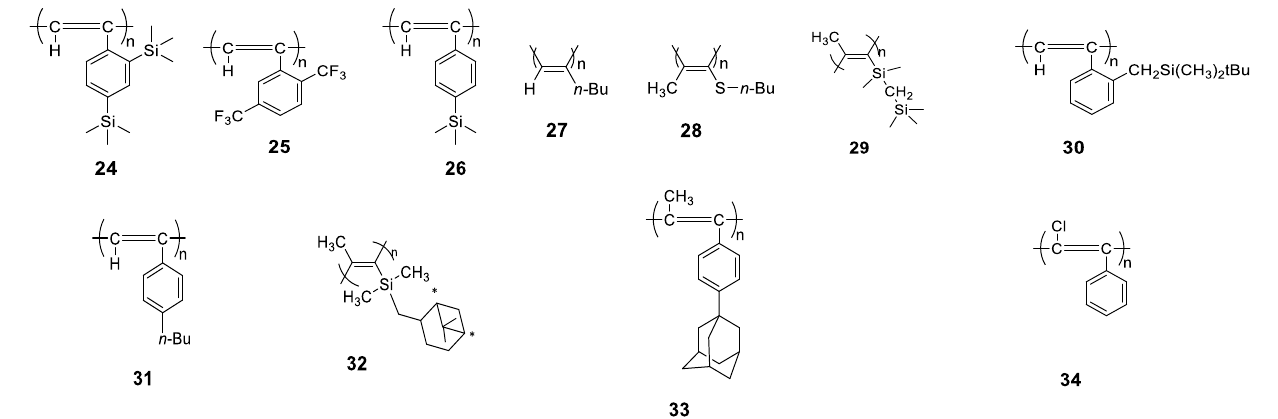
Polymers 2021 , 13 , x FOR PEER REVIEW Chart 2. Chemical structures of the membrane polymers in Figure 4 (PAs until 2013). For 1 – 9 , see Chart 1.